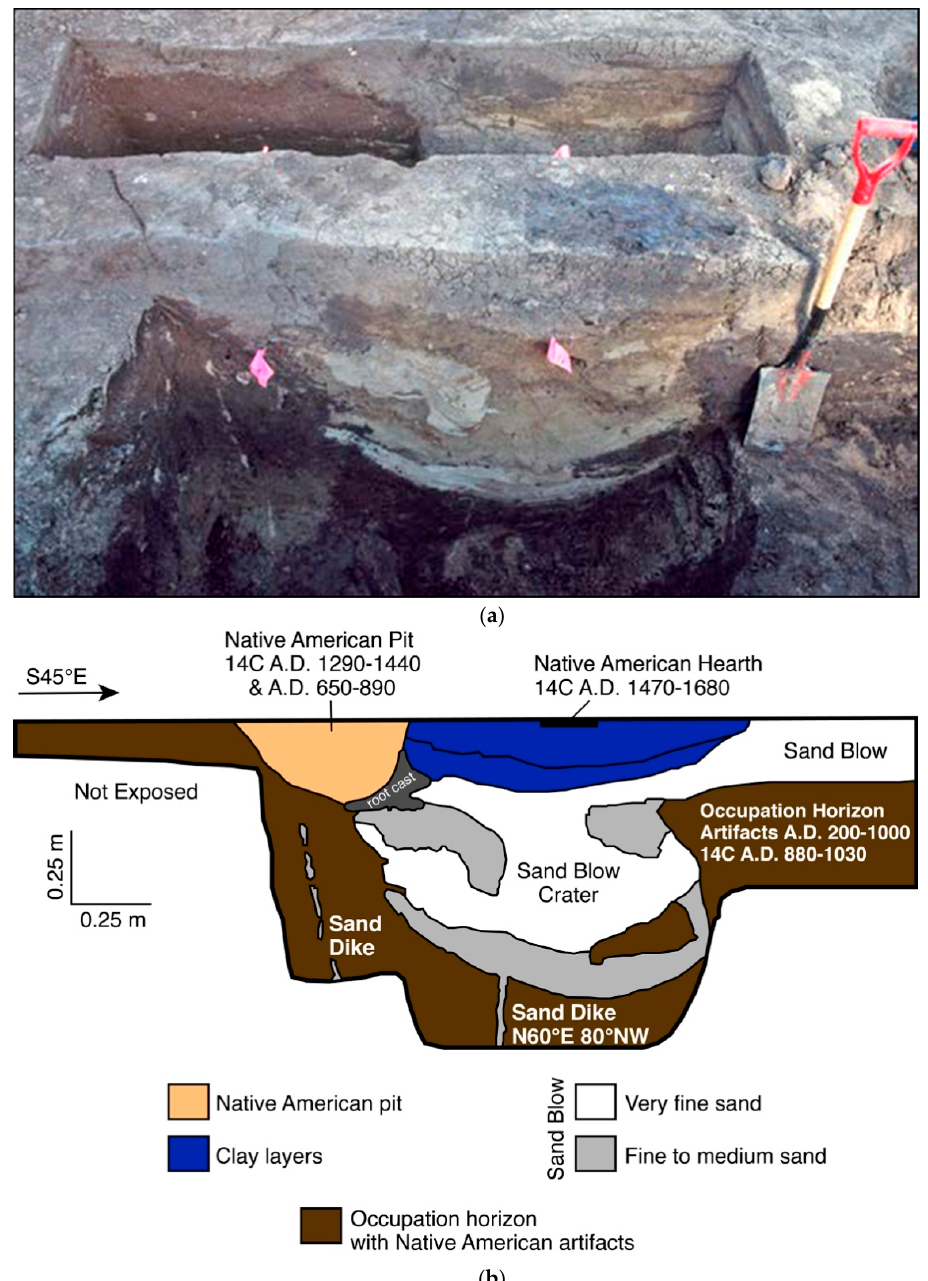
Figure 14. ( a ) Photograph of excavations and ( b ) log of trench wall at archeological site 3MS306 in northeastern Arkansas, showing relationships between the sand-blow crater, sand blow, sand dikes, and Native American hearth and pit above the sand-blow crater, and occupation horizon below the sand blow [130]. Also shown are two-sigma calibrated radiocarbon dates of organic samples collected from cultural features and horizon. On the basis of the artifact assemblage and radiocarbon dates, earthquake-induced liquefaction features are estimated to have formed in AD 900 ± 100